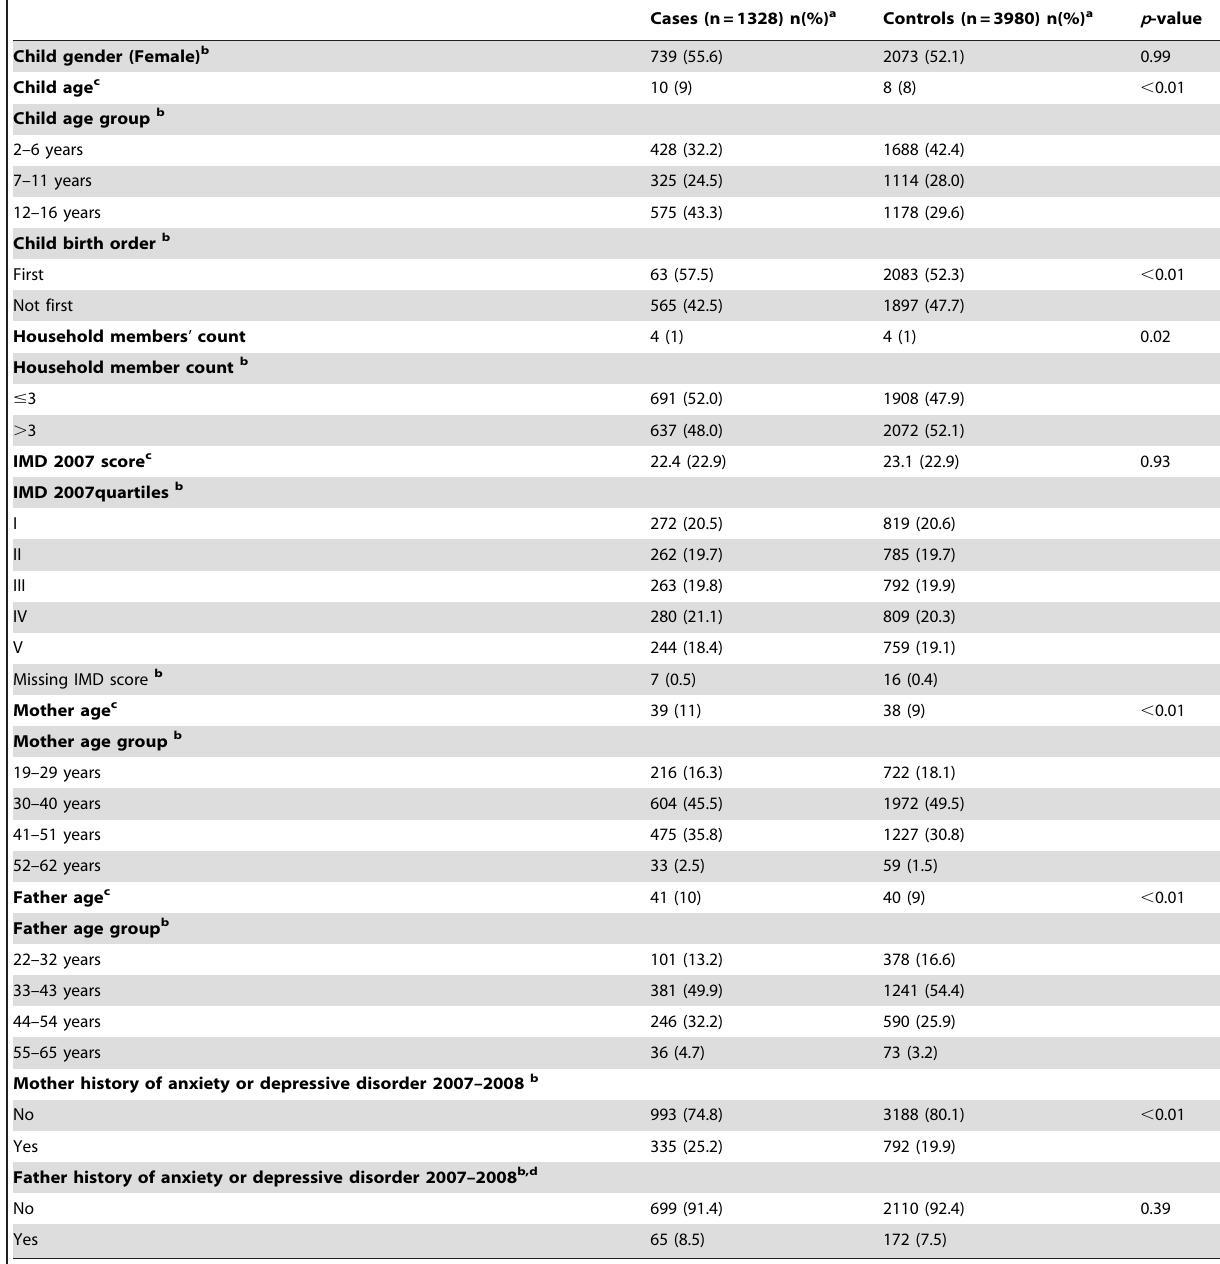
Table 2. Baseline characteristics of